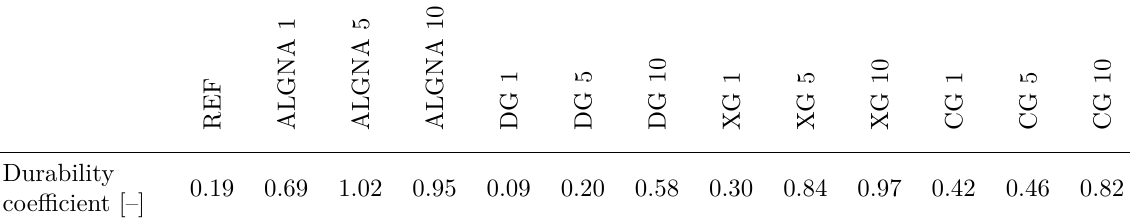
Table 1. Durability coefficient of tested